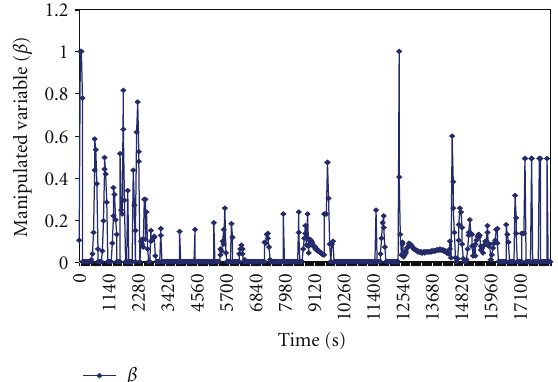
Figure 12: Evolution of the manipulated variable ( β ), K = 0.5, K r = 0.5.